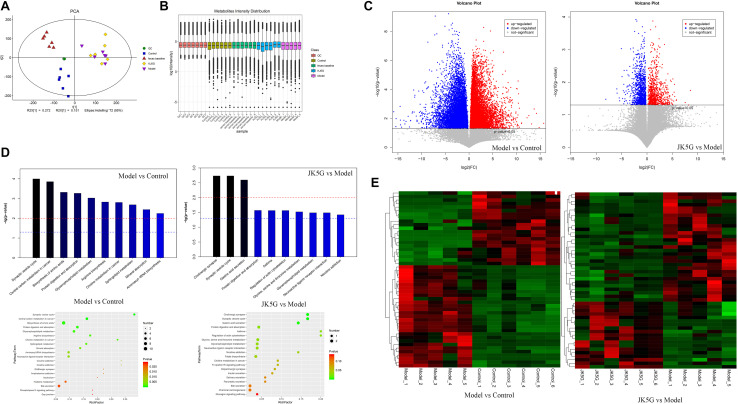
Different metabolites in feces on the model versus control groups, and the microecological preparation (JK5G) versus model groups. Principal component analysis (A), boxplot of metabolite strength (B), volcano plot of different metabolites in the model versus control groups, and the JK5G versus model groups (C), enrichment pathways of differential metabolites (D), heat map clustering of different metabolites in the model versus control groups, and the JK5G versus model groups (E).